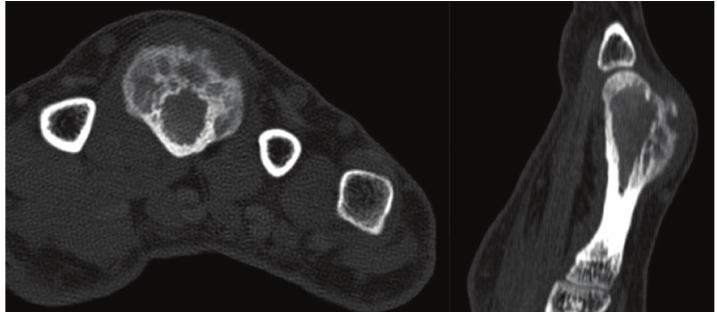
Figure 5: CT axial and sagittal images of the third metacarpal demonstrating a small focal area of continuity between the medullary cavity of the lesion and that of the underlying bone.